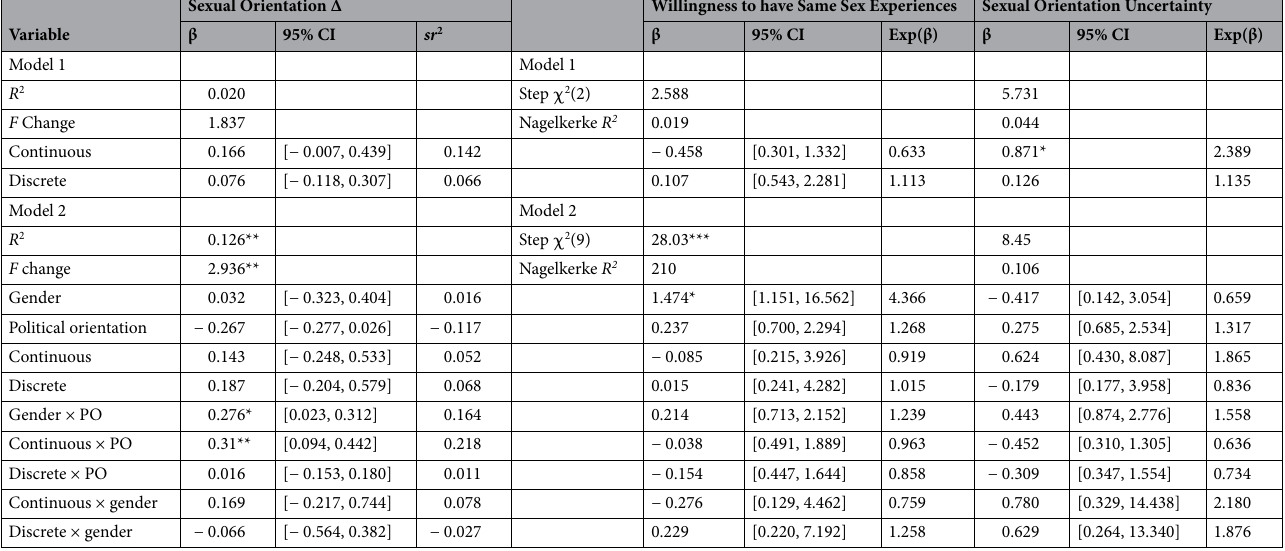
Table 1. Study 1. Effects of reading continuous or discrete accounts on sexual orientation self-ratings and secondary indices. PO political orientation. * p < 0.05; ** p < 0.01; *** p <